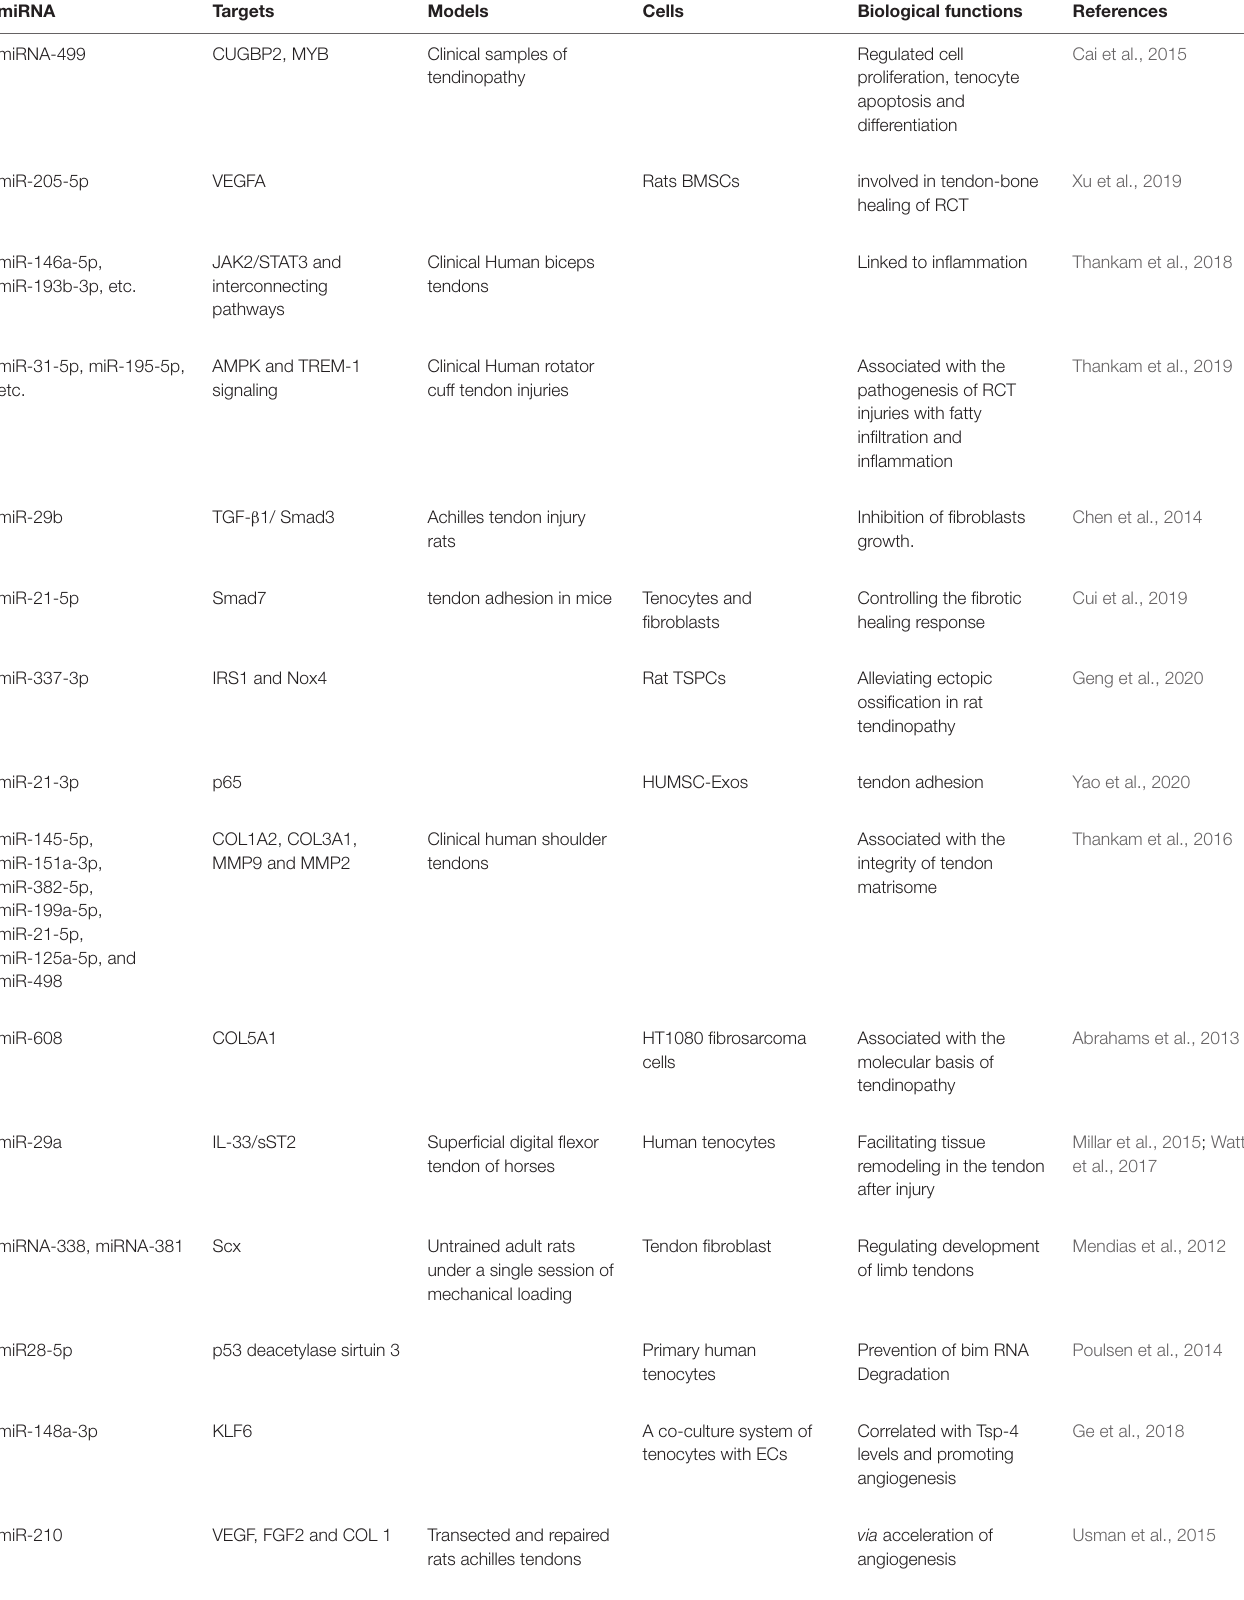
TABLE 1 | Summary of miRNAs in tendon